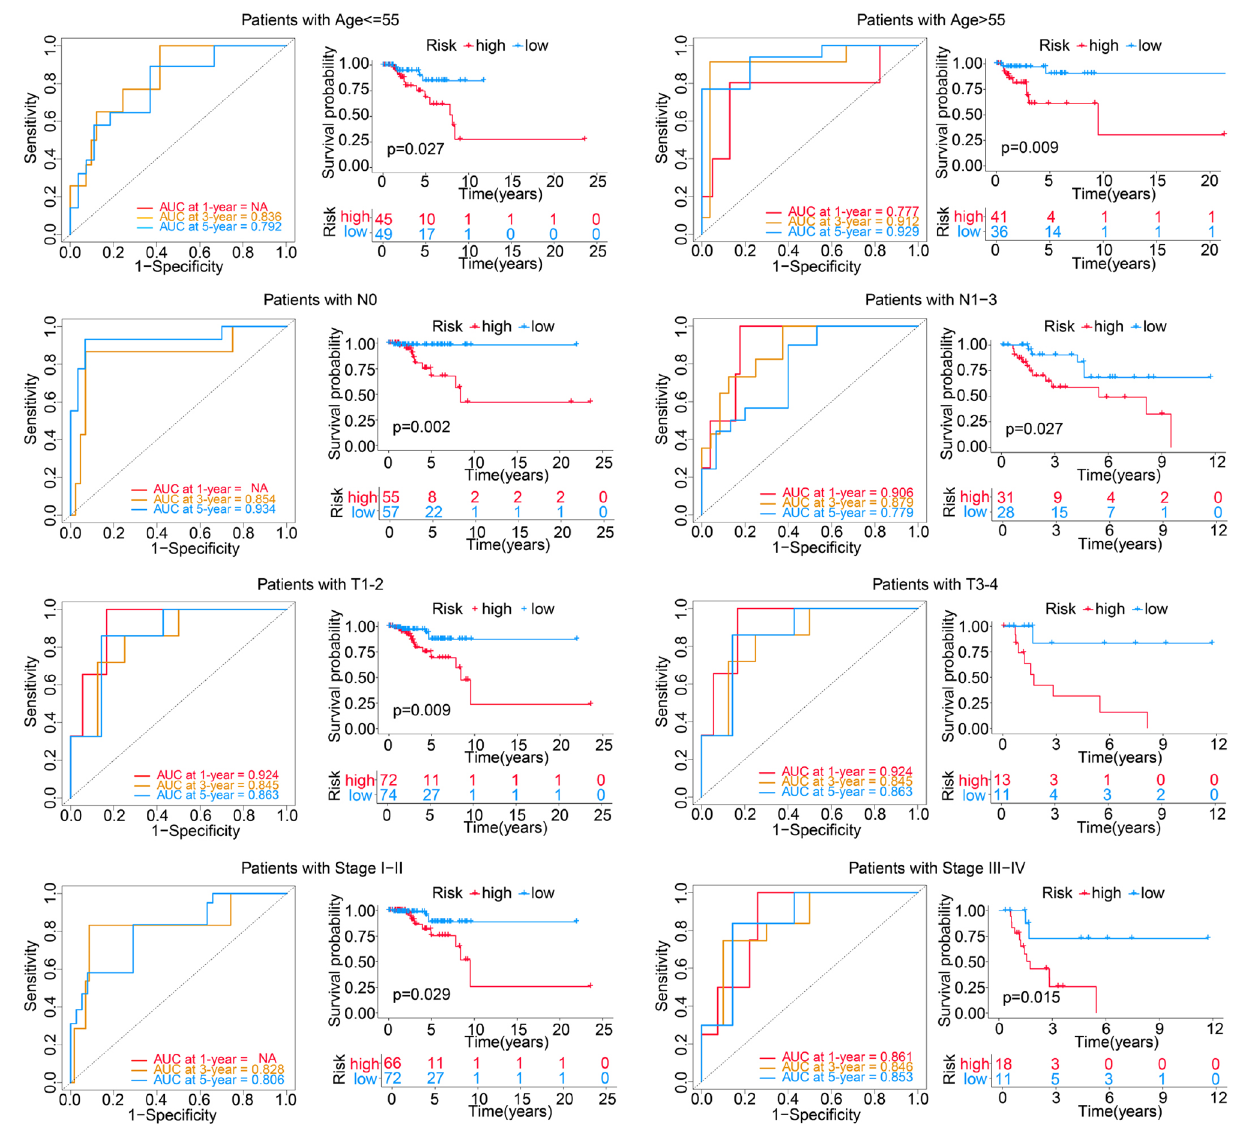
Figure 6. Time dependent ROC analysis and Kaplan–Meier survival analysis of the four-gene risk model in different clinical subgroups. NA: For less than two outcome events, no ROC curve was